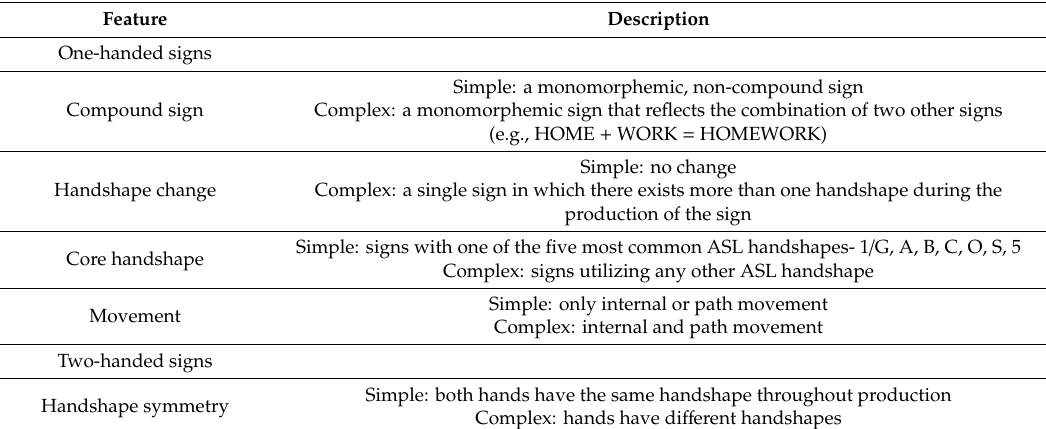
Table A1. Sign features considered for complexity rating on sign copying task.